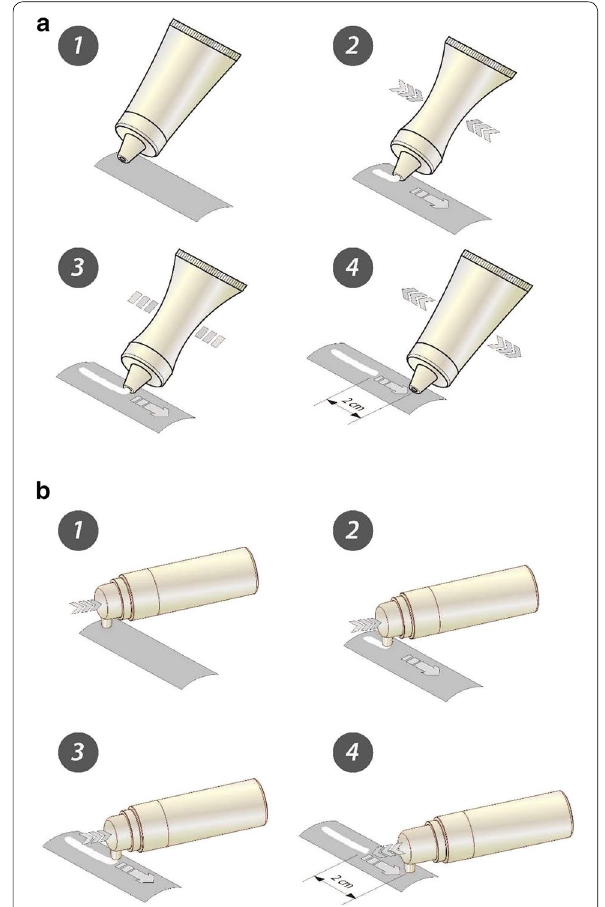
Fig. 1 Illustration of the contamination procedure developed to reproduce natural contamination due to skin contact under standardized conditions. For flexible packaging ( a ), the nozzle of the pack is pressed in contact with the contaminated compress (10 6 CFU/ mL) (1) and the dose (as defined by the provider) is released (2). When it is completely restituted (3), the pressure on the packaging is relieved and the movement is prolonged for a distance of 2 cm (4) to mimic manual wiping of the tip. This procedure can be adapted to rigid packaging ( b ) by replacing the pressure on the side of the pack by actuation of the delivery